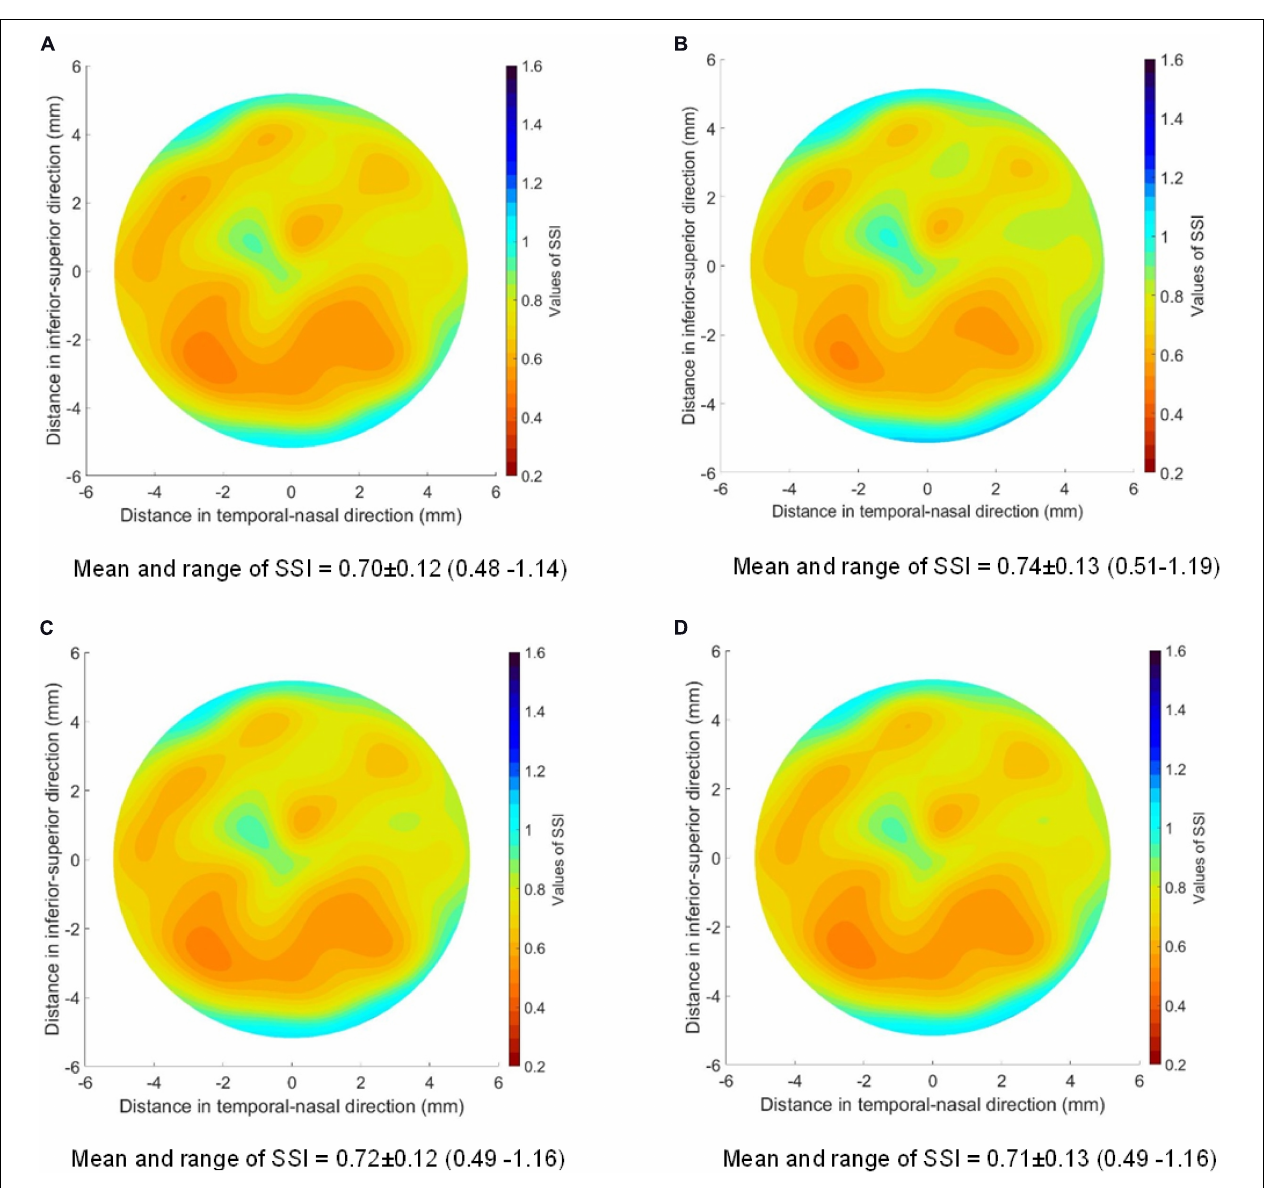
FIGURE 4 | SSI maps for four healthy corneas with the same SSI of 0.7 and different geometrical features and IOP. (A) IOP = 15 mmHg; CCT = 545 µ m; R = 7.8 mm; (B) IOP = 30 mmHg; CCT = 545 µ m; R = 7.8 mm; (C) IOP = 15 mmHg; CCT = 445 µ m; R = 7.8 mm; (D) IOP = 15 mmHg; CCT = 545 µ m; R = 8.4 mm. The values of SSI for each case were mean value ± standard deviation (range from minimum to maximum value). The peripheral thickness was set to 150 microns more than CCT in these